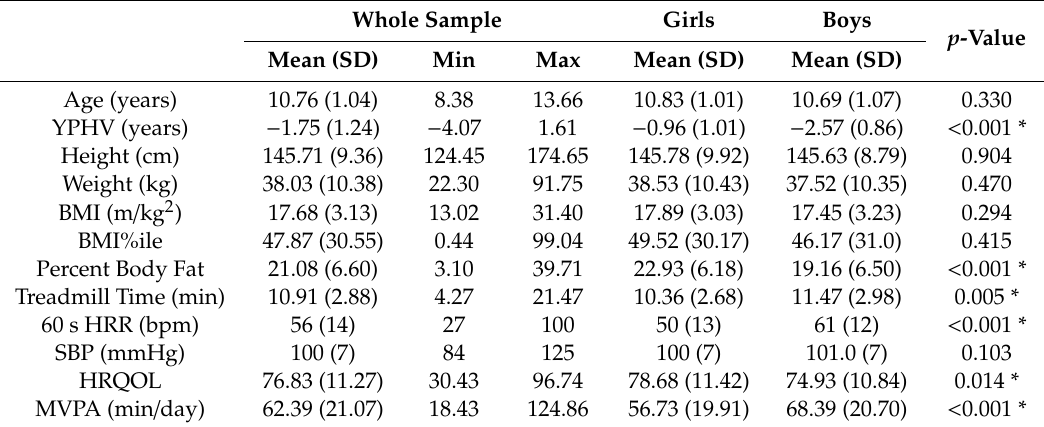
Table 1. Participant demographics and descriptive